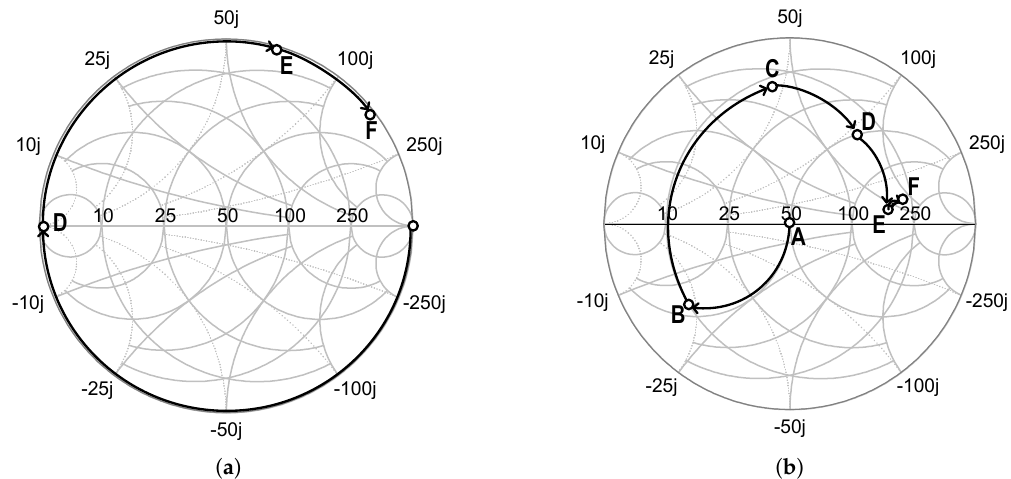
Figure 7. Trajectories for input impedance matching, ( a ) third harmonics and ( b )